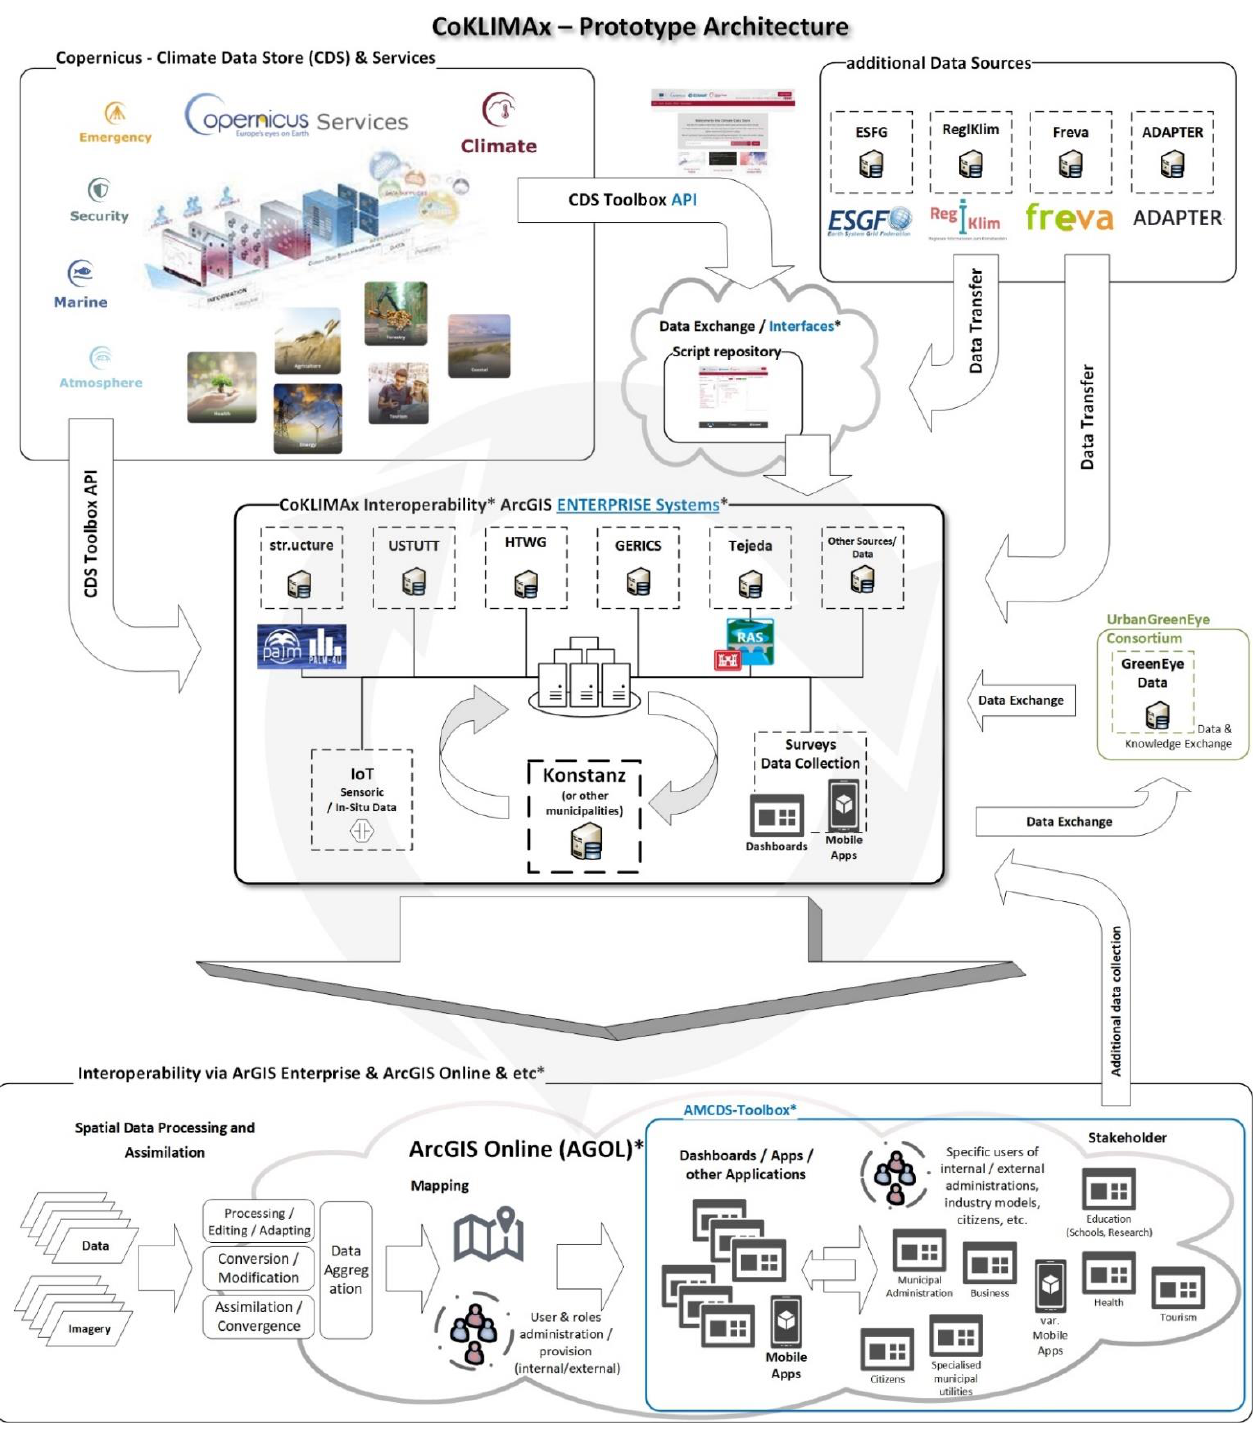
Figure 1. Data sources, data streams, and data processing functionalities in the present application context, including the AMCDS toolbox (highlighted in blue). Please note that the figure depicts exemplary commercial software applications (*), however, CoKLIMAx will also utilize and apply open-source software to complement the described components.